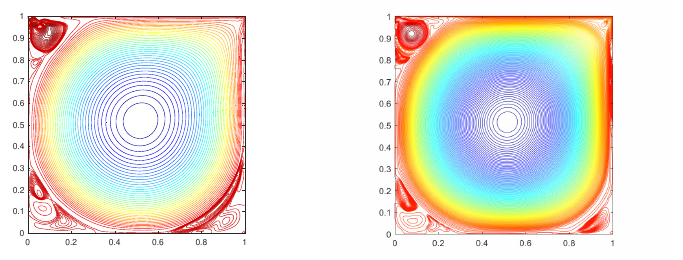
Figure 6. Computed streamlines for lid-driven cavity flow at Re=30000(left),Re=50000(right).